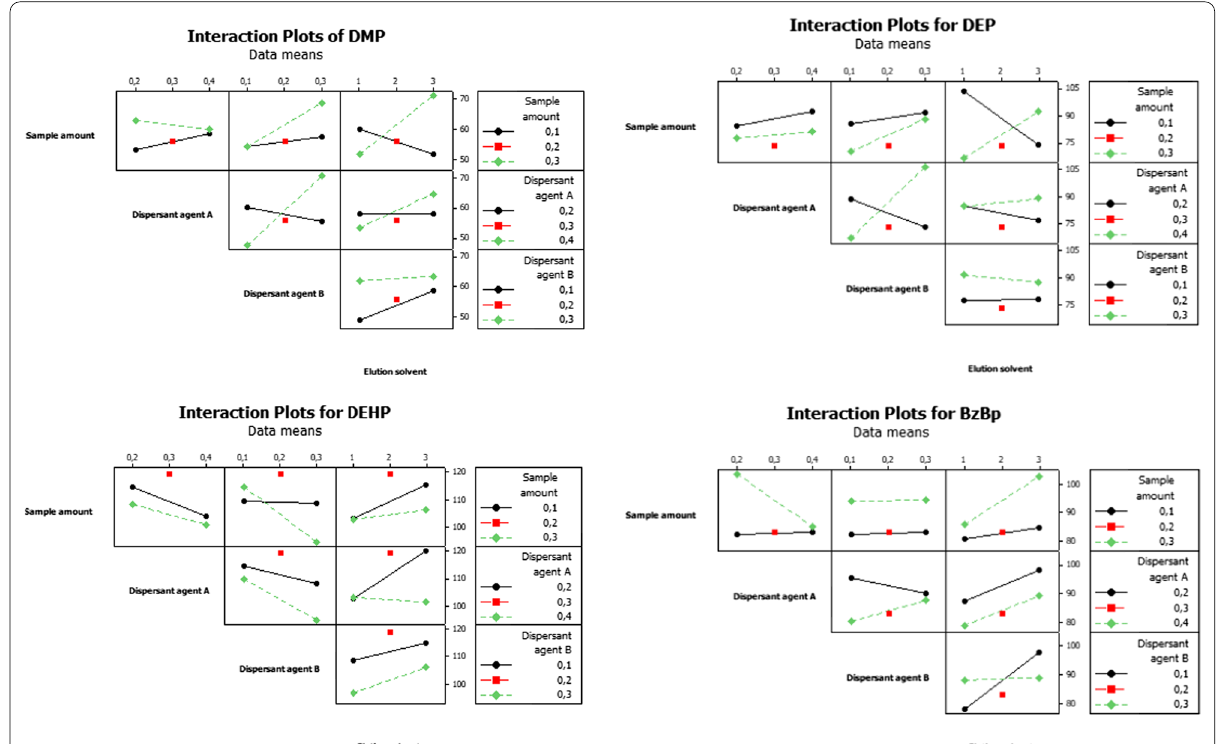
Fig. 2 Interaction plot of DMP (dimethyl phthalate), DEP (diethyl phthalate), DEHP (diethyl hexyl phthalate) and BzBP (benzyl butyl phthalate) for the four studied parameters (sample, dispersant agent A and dispersant agent B amounts, and solvent